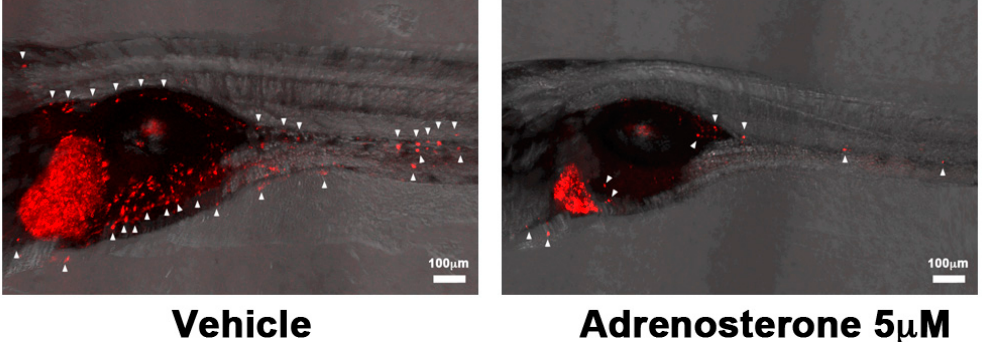
Figure 3. Examples of phenotype-based screening in zebrafish. Metastatic dissemination of mCherry-positive cells from the liver of vehicle (left) or adrenosterone (right)-treated Twist1-ER T2 / xmrk double-transgenic fish. White arrows indicate disseminated mCherry-positive cells. Images are